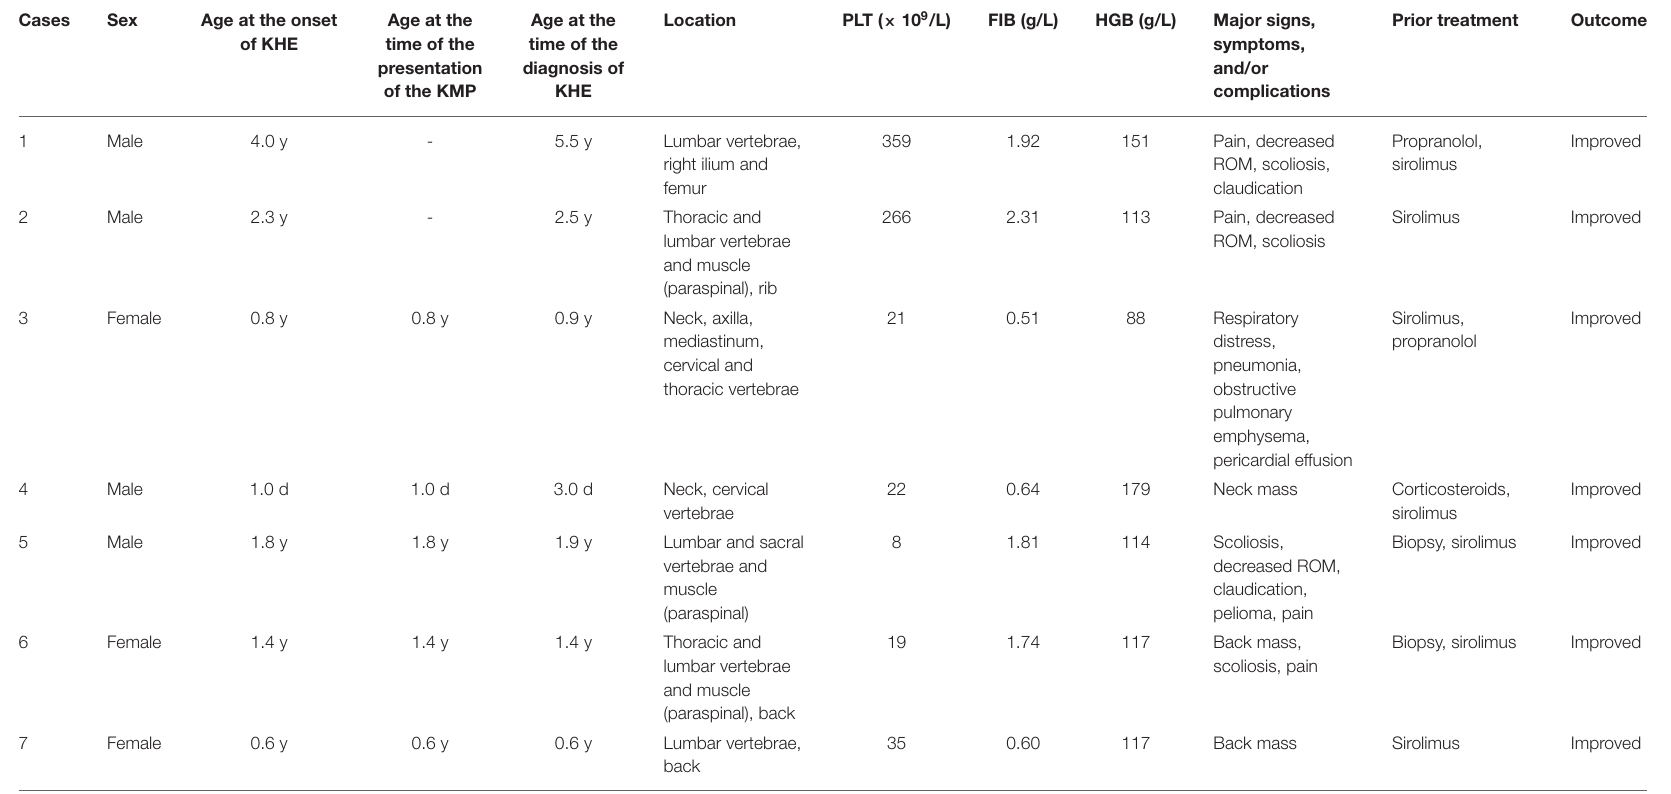
TABLE 1 | Clinical characteristics of patients with KHE involving the spine*.